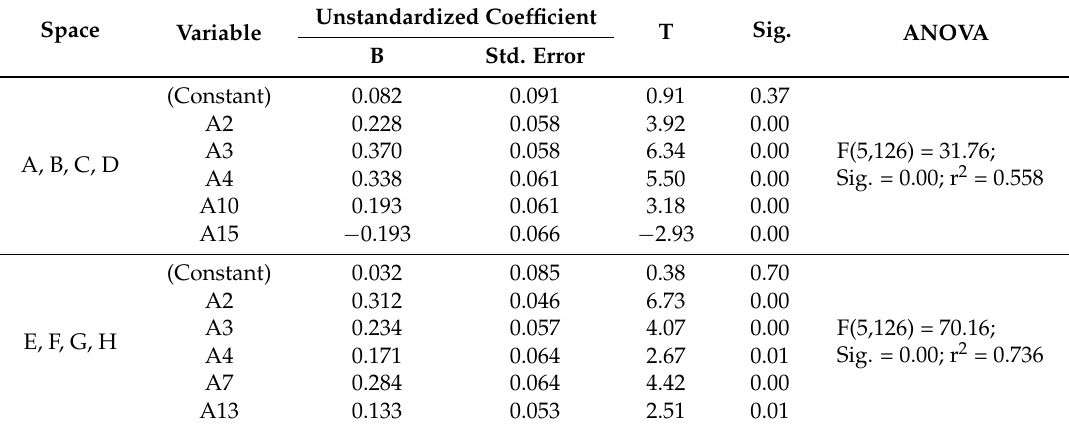
Table 6. Relationship between spatial factors and occupants’ perception of